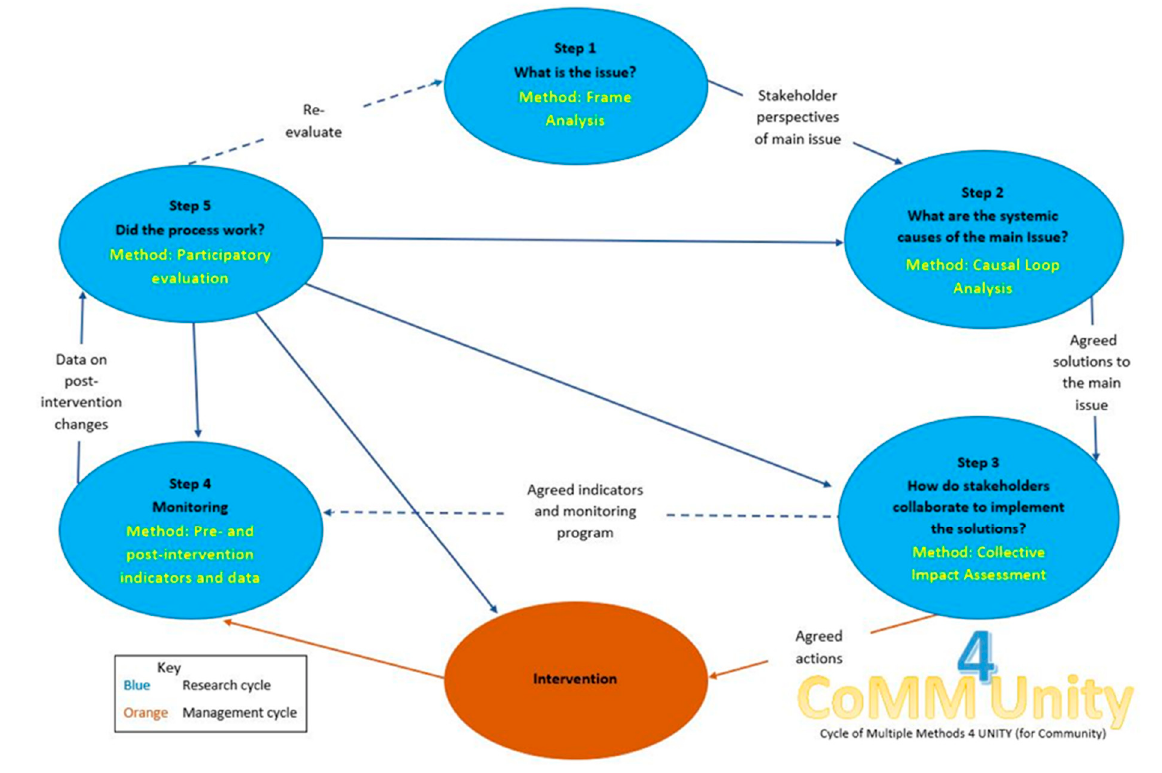
Figure 1. The Comm4Unity framework [31].